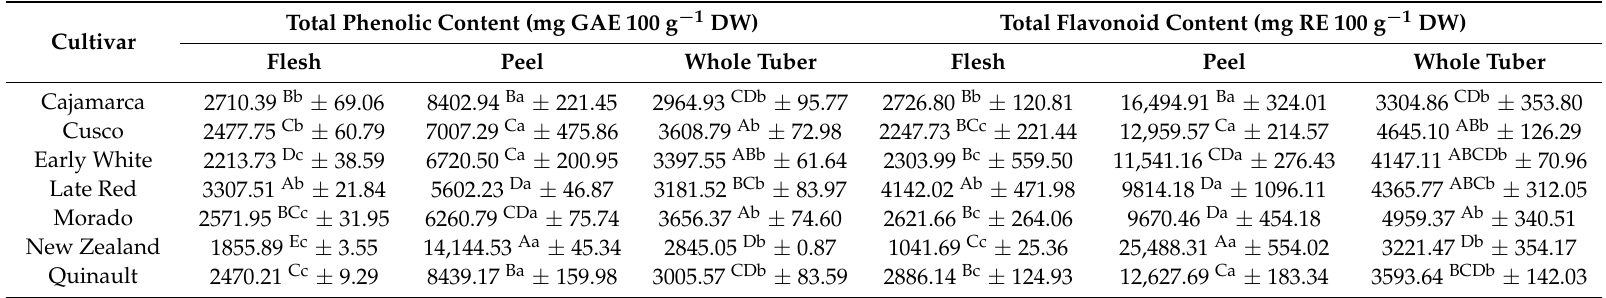
Table 4. Total phenolic content (mg GAE 100 g − 1 DW) and total flavonoid content (mg RE 100 g − 1 DW) in the flesh, peel, and whole tuber of different yacon